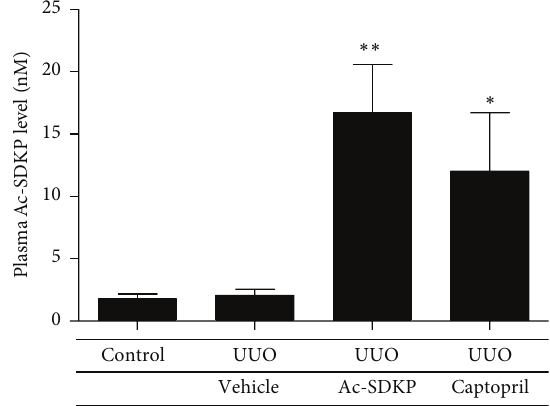
Figure 1: Plasma Ac-SDKP levels in different experimental groups. Data were expressed as mean ± SEM. ∗ 𝑃 < 0.05 ; ∗∗ 𝑃 < 0.01 ; ∗∗∗ 𝑃 < 0.001 versus the corresponding group of sham-operated mice; # 𝑃 < 0.05 ; ## 𝑃 < 0.01 versus UUO-vehicle animals in the same operation